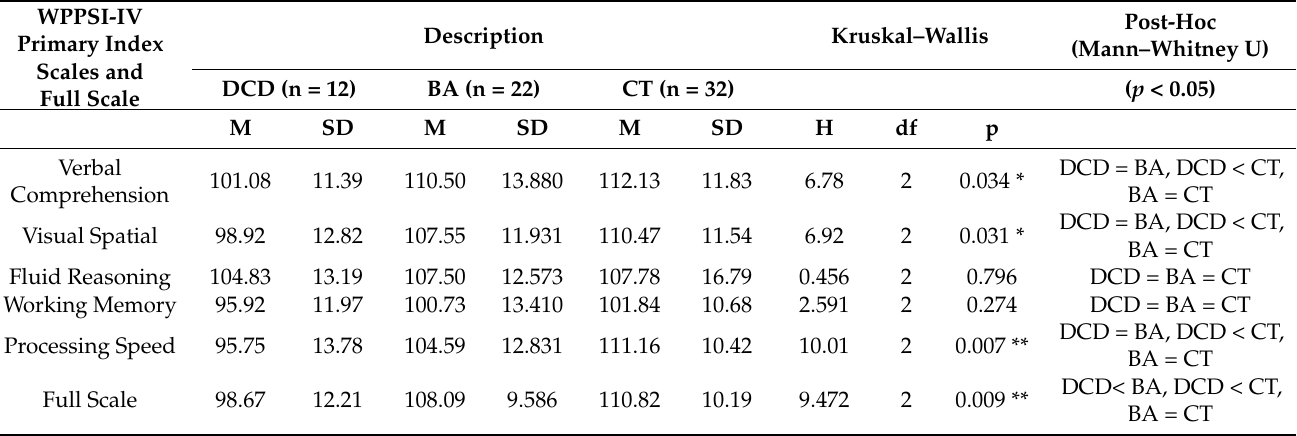
Table A1. Mean and standard deviation for all primary WPPSI-IV indices by group and results of Kruskal–Wallis test and Mann–Whitney U.